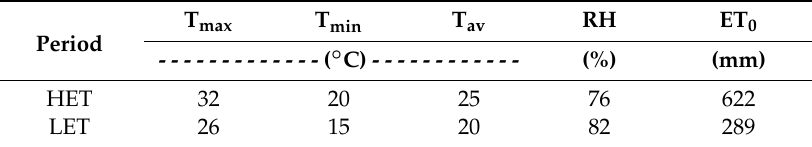
Table 1. Climate parameters during high evapotranspiration (HET) and low evapotranspiration (LET) growing cycles. T max = average of maximum temperature; T min = average of minimum temperature; T av = average temperature; RH = relative humidity; ET 0 = potential evapotranspiration calculated by the method of Penman–Monteith (FAO 56